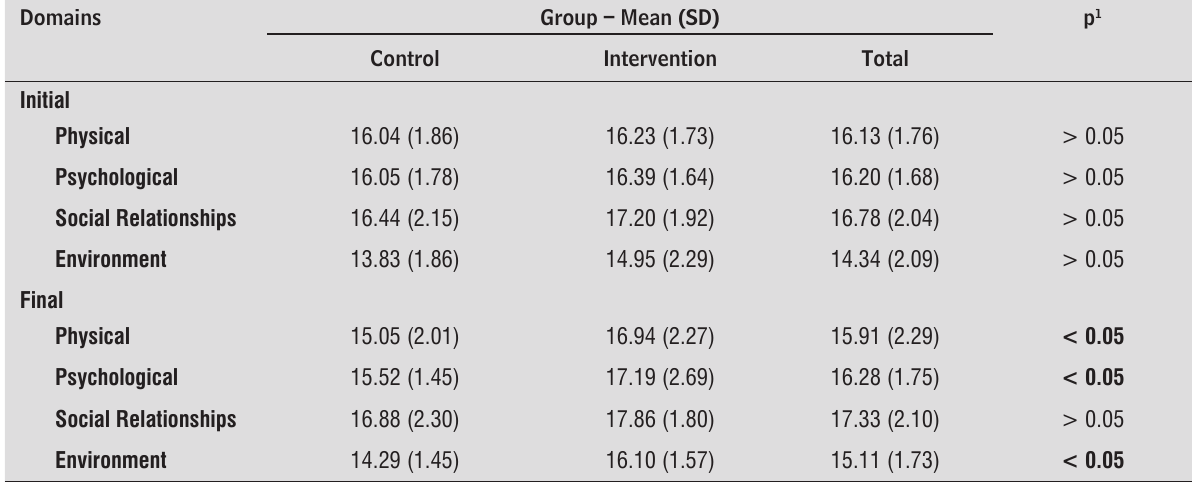
Table 1 - Distribution of initial and final means and standard deviations (SD) of scores of the quality of life domains in the WHOQOL-BREF scale, according to groups